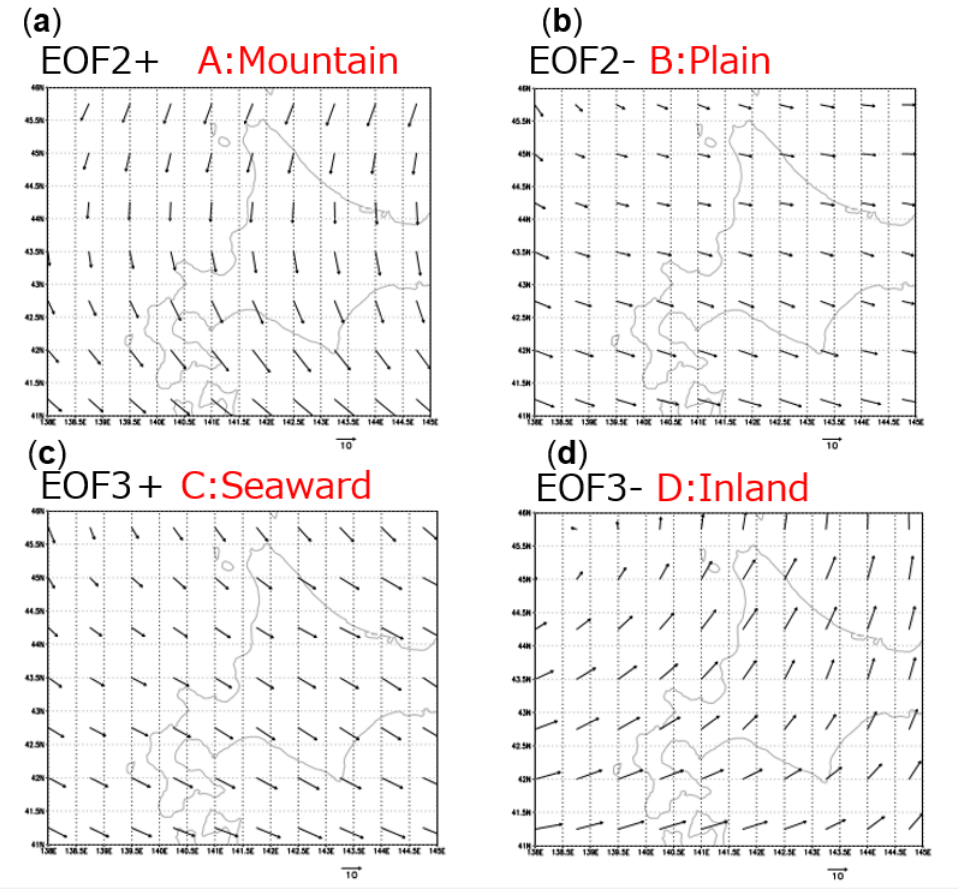
Figure 8. Distribution of wind vectors at 850 hPa level. ( a ) mountain, ( b ) plain, ( c ) seaward, and ( d ) inland patterns.